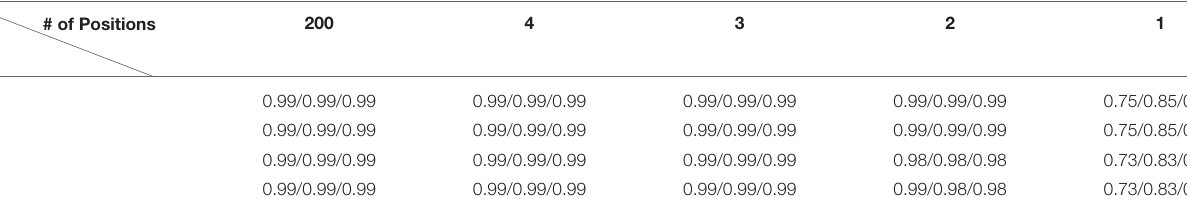
TABLE 2 | The class-wise averaged approximated precision/recall/f1-score values for the corresponding four machine learning (ML) algorithm by five experiments. # of Positions 200